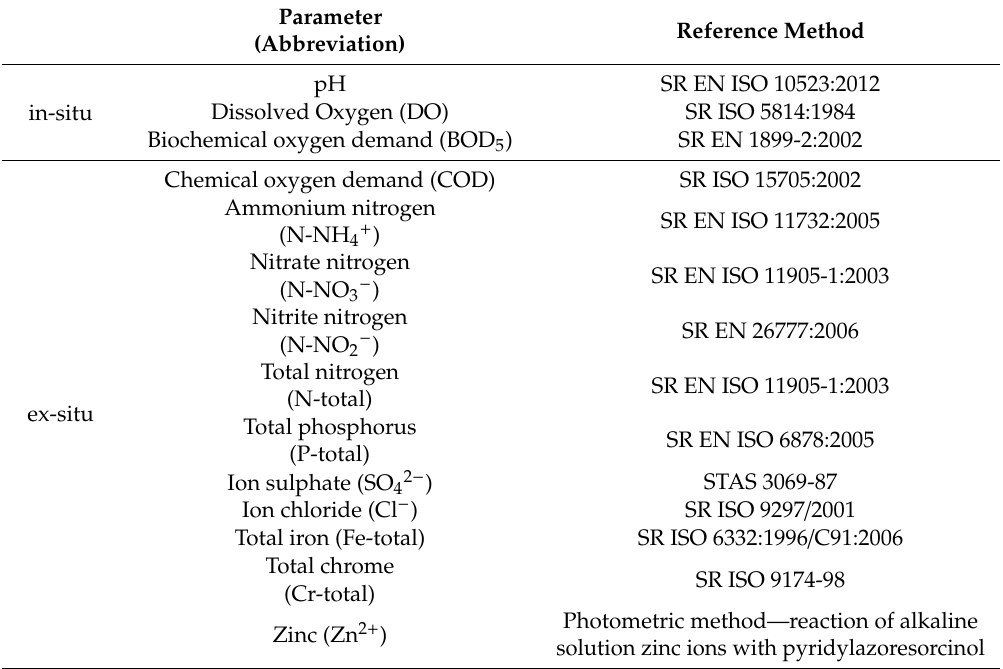
Table 1. Physico-chemical parameters and reference methods used